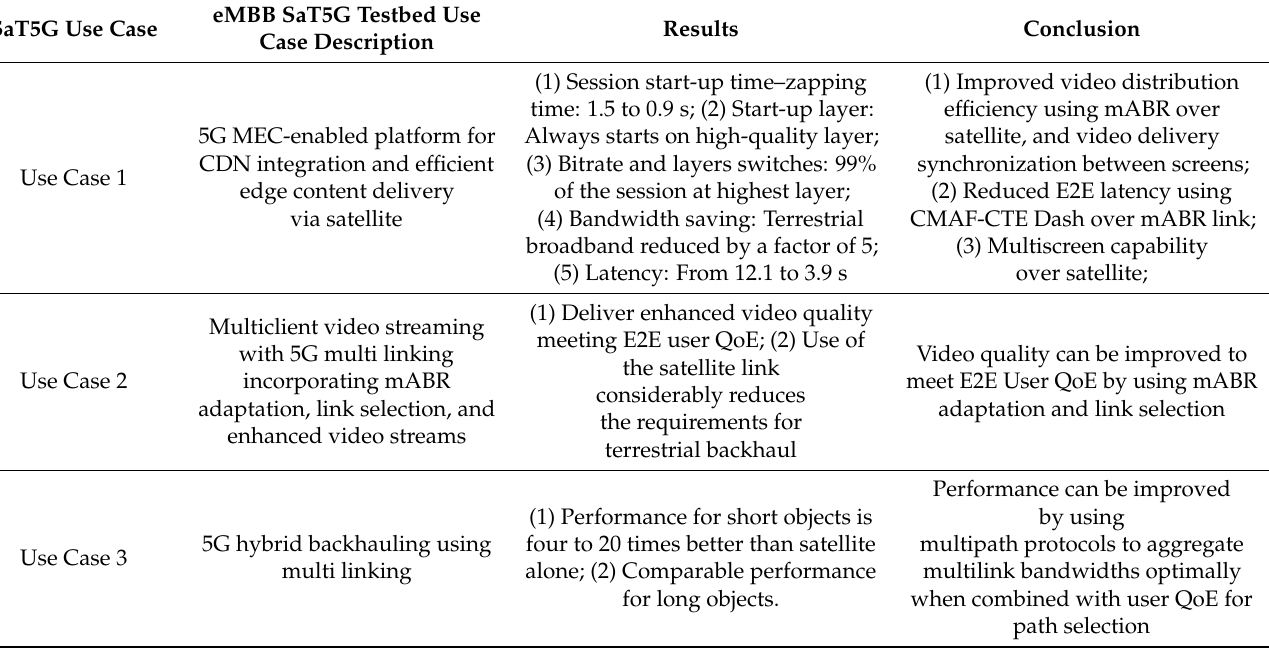
Table 5. A Summary of Key SaT5G Testbed Results.